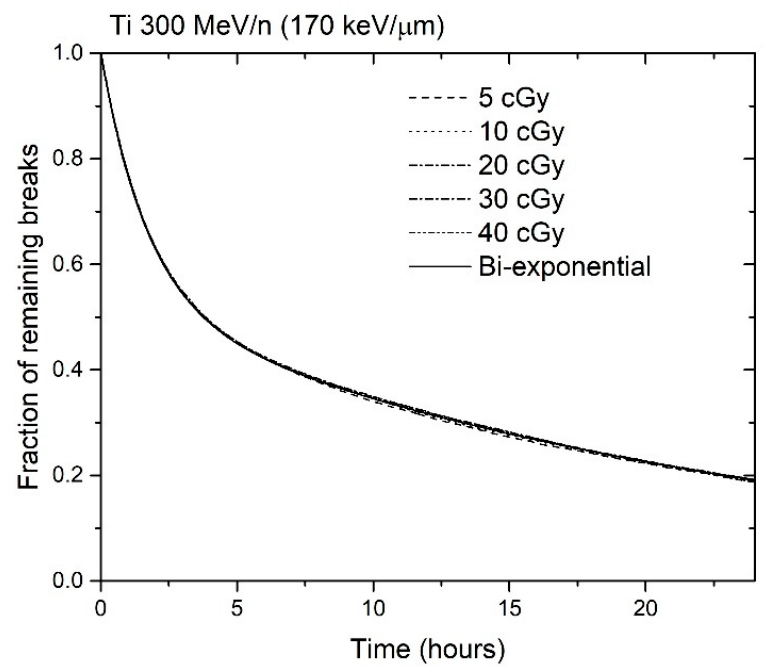
Figure 5. Fraction of remaining breaks as a function of time, after 5, 10, 20, 30, or 40 cGy Ti 300 MeV / n (170 keV / µ m). A theoretical bi-exponential curve is also shown. The results were obtained using 10,000 simulation histories for each dose.